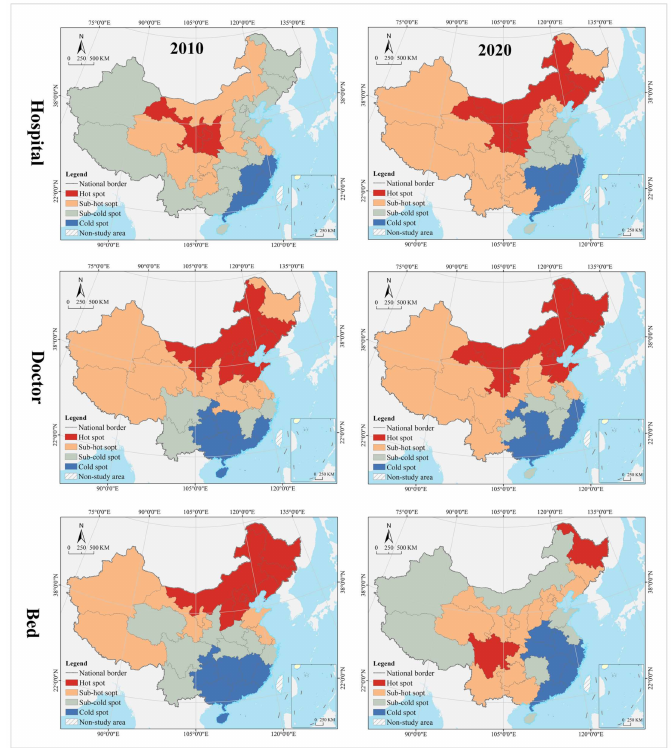
Figure 8. Spatial cold and hot spots analysis of mismatch type for demand.